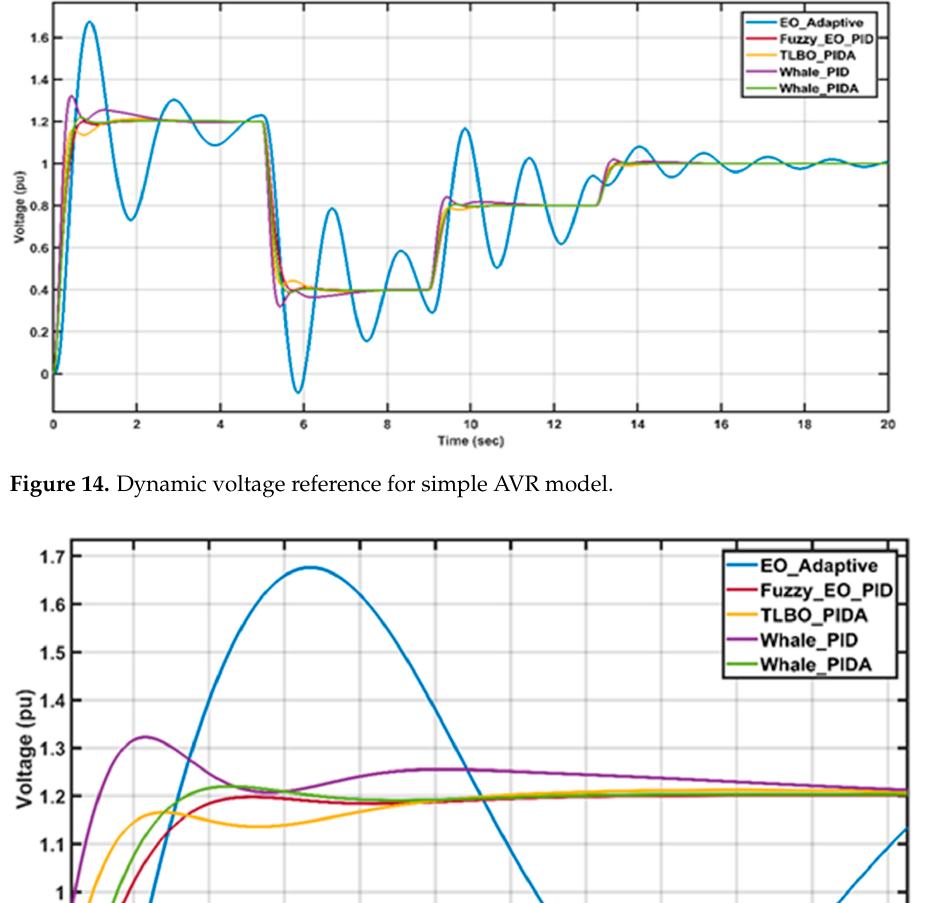
Energies 2022 , 15 , x FOR PEER REVIEW Figure 15. Focusing part 1 on the dynamic reference case. Figure 15. Focusing part 1 on the dynamic reference case. Figure 15. Focusing part 1 on the dynamic reference case.